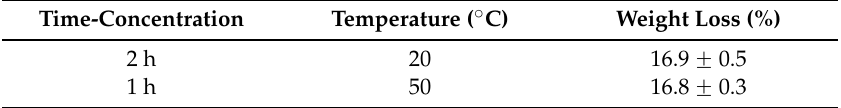
Table 6. Weight loss in in PE/Whey/PET samples treated with 4% Savinase at 20 °C, and 50 °C.